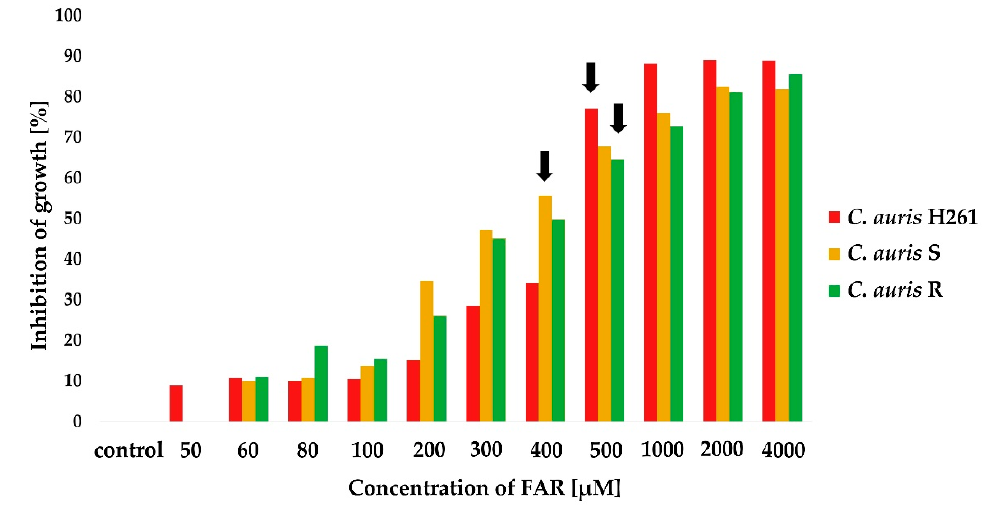
Figure 2. Inhibitory effect of FAR on the planktonic cells of C. auris determined by MIC 50 (labeled with black arrows). Optical density (OD 580 ) of suspension was determined after 24 h cultivation of yeast in the presence of different concentrations of FAR; the control sample was without FAR. Percentage of growth inhibition was calculated from the OD 580 values of samples compared to the inhibition of the control sample set to 0%. Data represent the average of 3 independent experiments performed in triplicate.